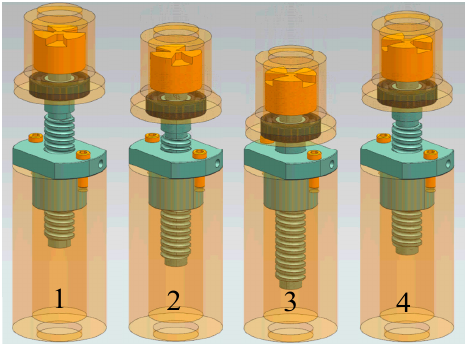
Figure 1. Ball screw inerter.